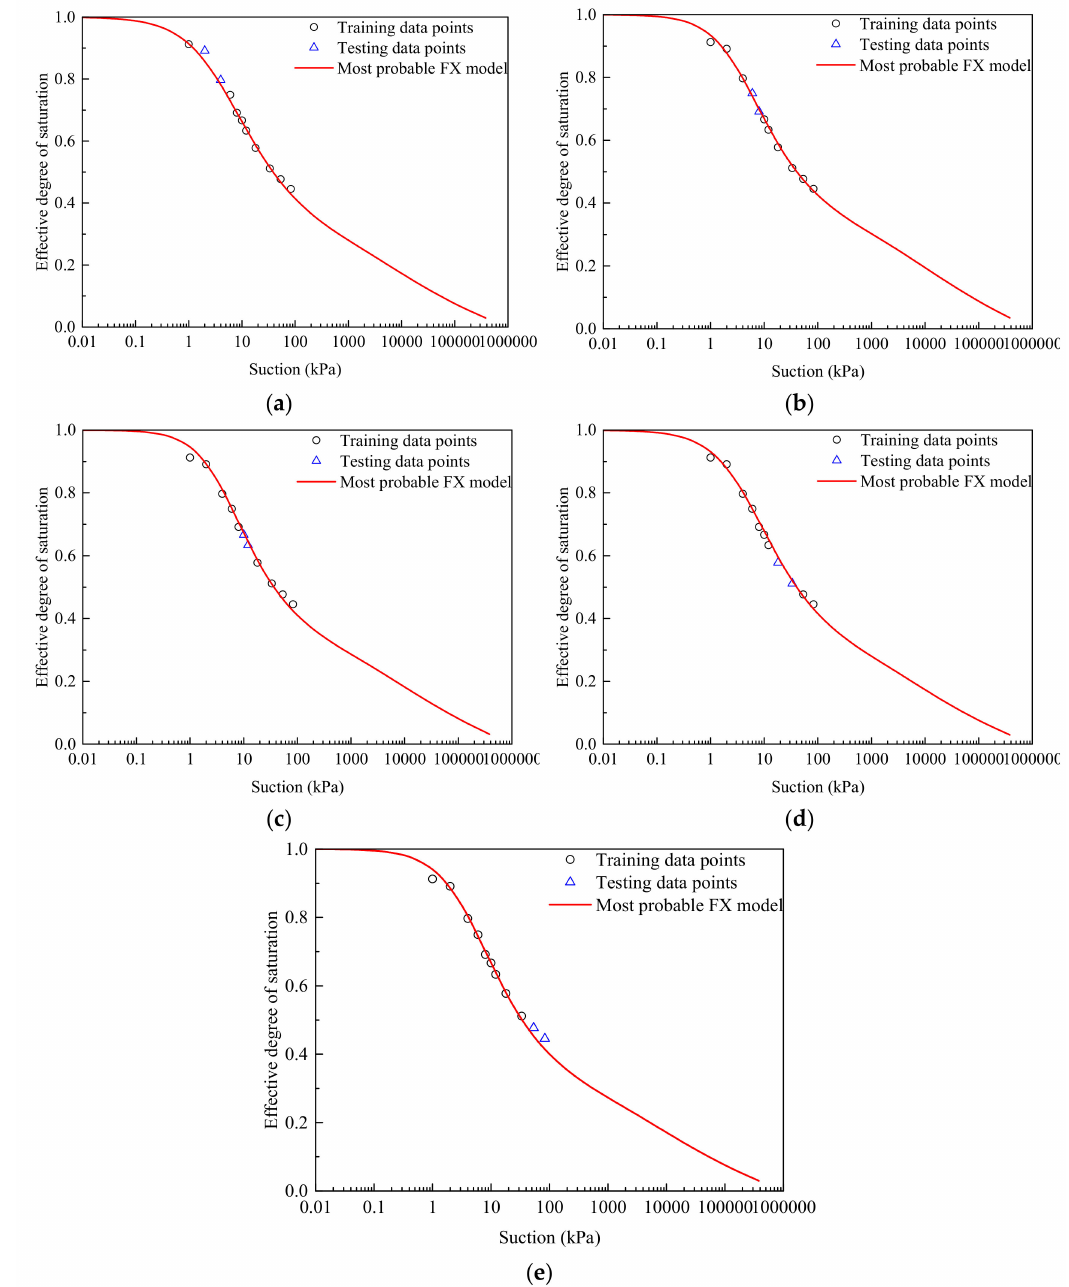
Figure 2. Cross-validation results of soil code 3190 in Unsaturated Soil Database